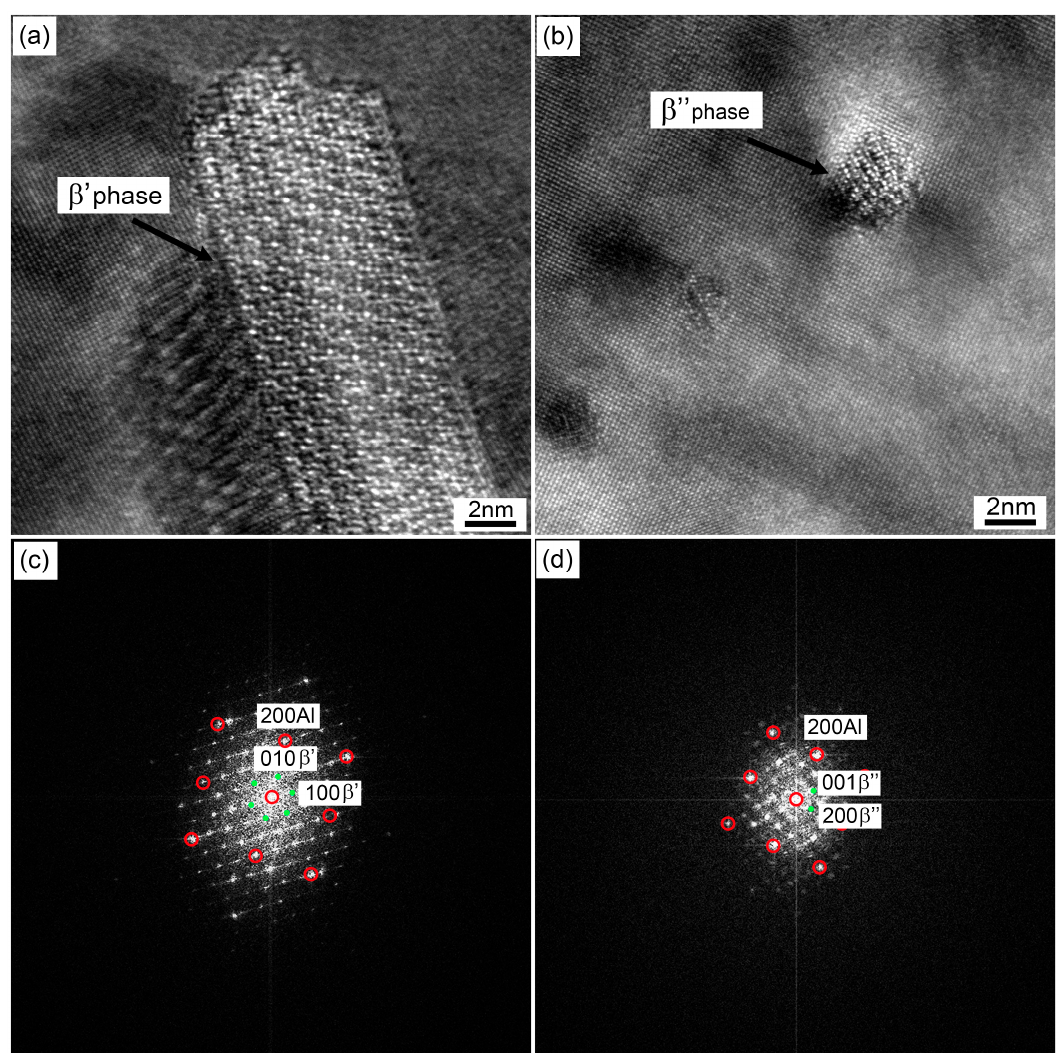
Figure 13. ( a ) and ( b ), HRTEM images of the large rod-like and fine needle-like precipitates in Figures 11 and 12 (red arrows marked); and ( c ) and ( d ), the corresponding FFT (Fast Fourier Transform) patterns from samples in ( a ) and ( b ).